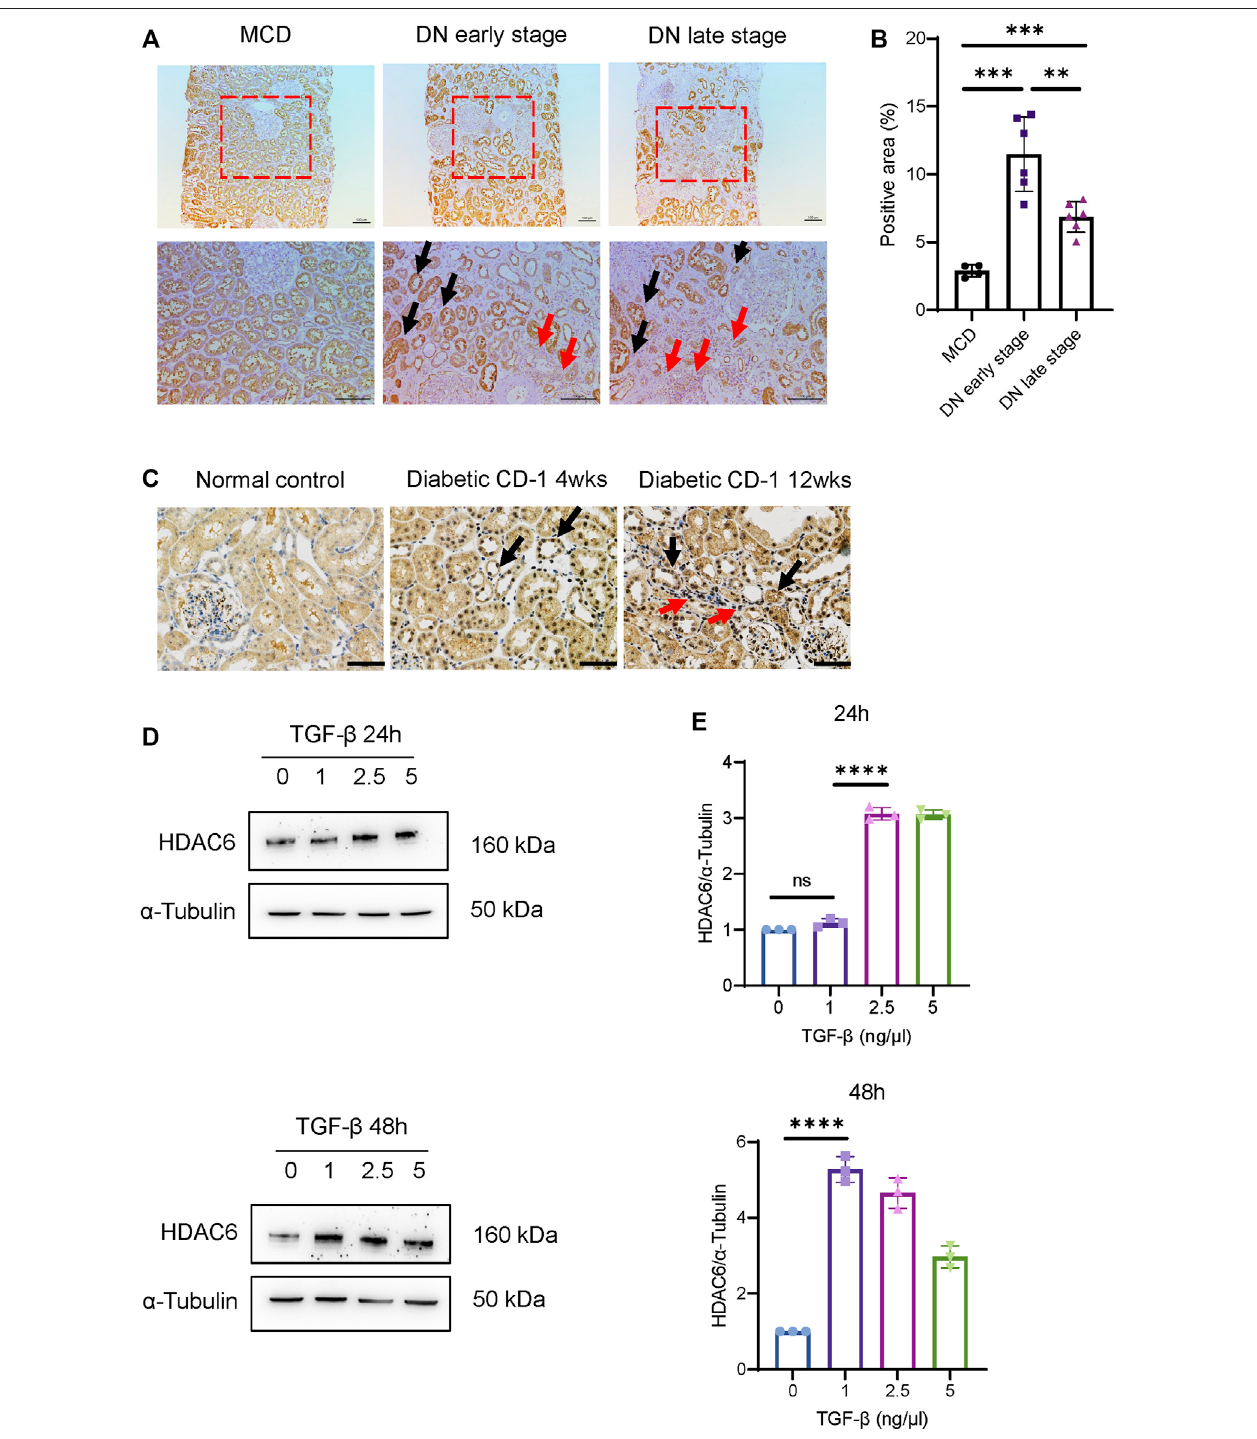
FIGURE 2 | HDAC6 upregulation is associated with tubular injury. (A) IHC staining images of HDAC6 expression distribution in renal tissues from DN patients and MCD. HDAC6isincreased intubularcells(black arrows)and intrarenalmacrophages(redarrows).Scalebar,100 µm. (B) Quanti fi cationofHDAC6IHC staining. n =4in the healthy control group, n = 6 in the early-stage DN group, n = 6 in the late-stage DN group. (C) IHC staining images of HDAC6 expression distribution in renal tissues from diabetic CD-1 mice and normal control. HDAC6 isincreased in tubular cells (black arrows) and tubulointerstitial in fi ltrated cells (red arrows). Scale bar, 50 µm. (D) Representative western blot analysis and (E) quanti fi cation of HDAC6 levels in HK-2 cells treated with TGF- β for 24 h or 48 h at different dosages as indicated. ** p < 0.01; *** p < 0.001; **** p < 0.0001. Unpaired two-tailed t test.